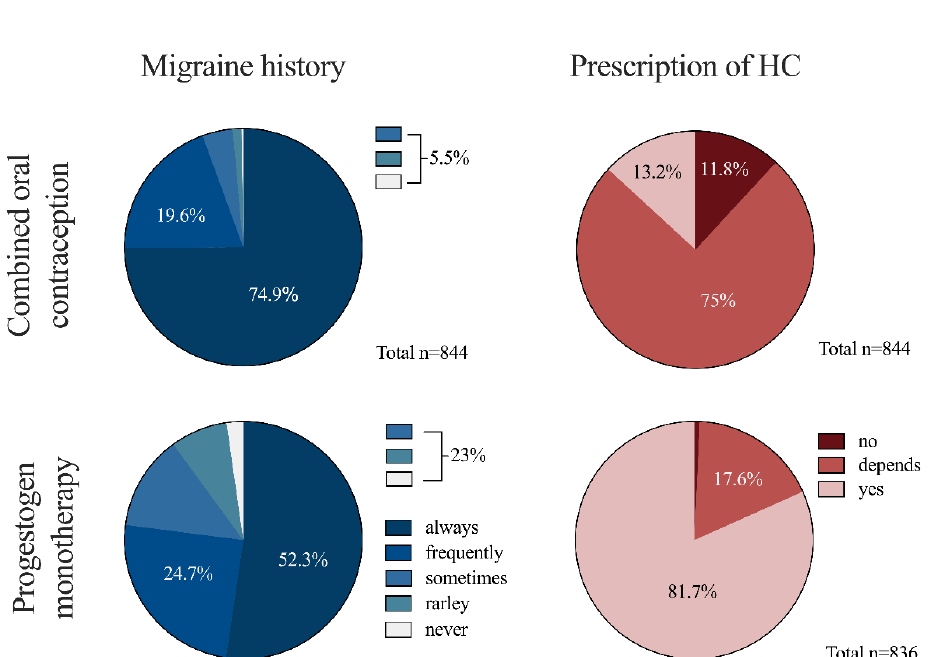
Figure 2. Hormonal contraception and migraine. The figure shows the absolute frequencies of asking about migraine (including migraine with and without aura) before initiating treatment with COC or PM, as well as prescribing patterns of COC and PM in the case of concomitant migraine. The presence of migraine influences gynecologists in their decision whether to pre- Table 2. Factors limiting HC prescription in concomitant scribe COC (Figure 2): 12% ( n = 100/844) of participants never prescribed COC for women suffering from migraine. Another 75% ( n = 633/844) would do so only to a limited extent. The proportion of gynecologists who prescribed COC without restrictions in patients suf- fering from migraine ( n = 104/190) was significantly younger than those who never pre- scribed a COC in migraine patients ( n = 86/190) (50 ± 0.8 age in years [SEM] vs. 54 ± 0.9 age in years [SEM], respectively; U = 3115,5, z = −3 .598, p < 0.001, Mann – Whitney-U). When asked about potential factors influencing their decision (multiple answers allowed), the presence of cardiovascular risk factors (not further specified) (78%, n = 494/633) and other comorbidities (71%, n = 447/633) were listed most frequently (Table 2).